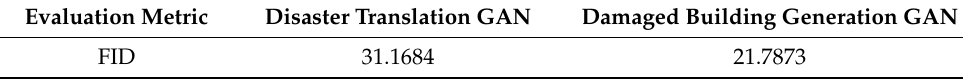
Table 7. FID distances of the